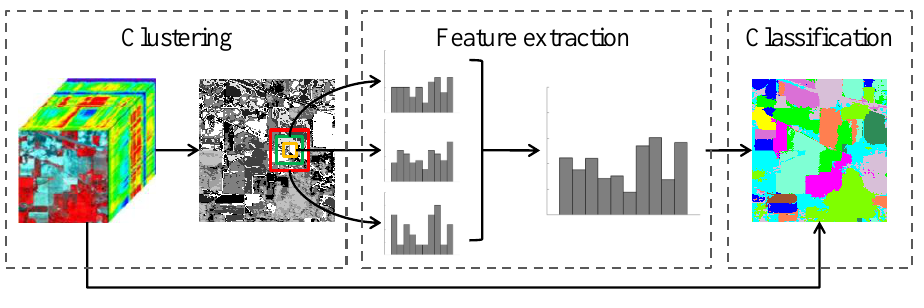
Figure 1. Flowchart of the multiscale cluster histogram (MCH)